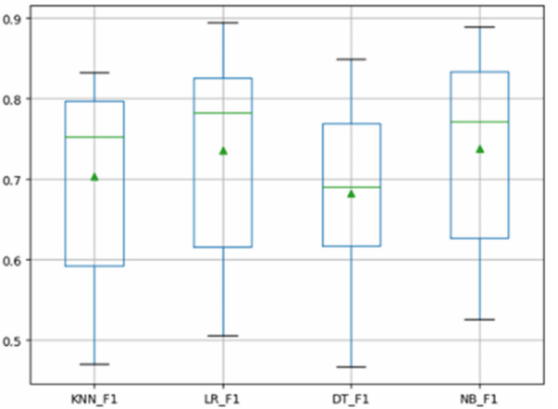
Figure 4. F1 values obtained by different classifiers on the Relink